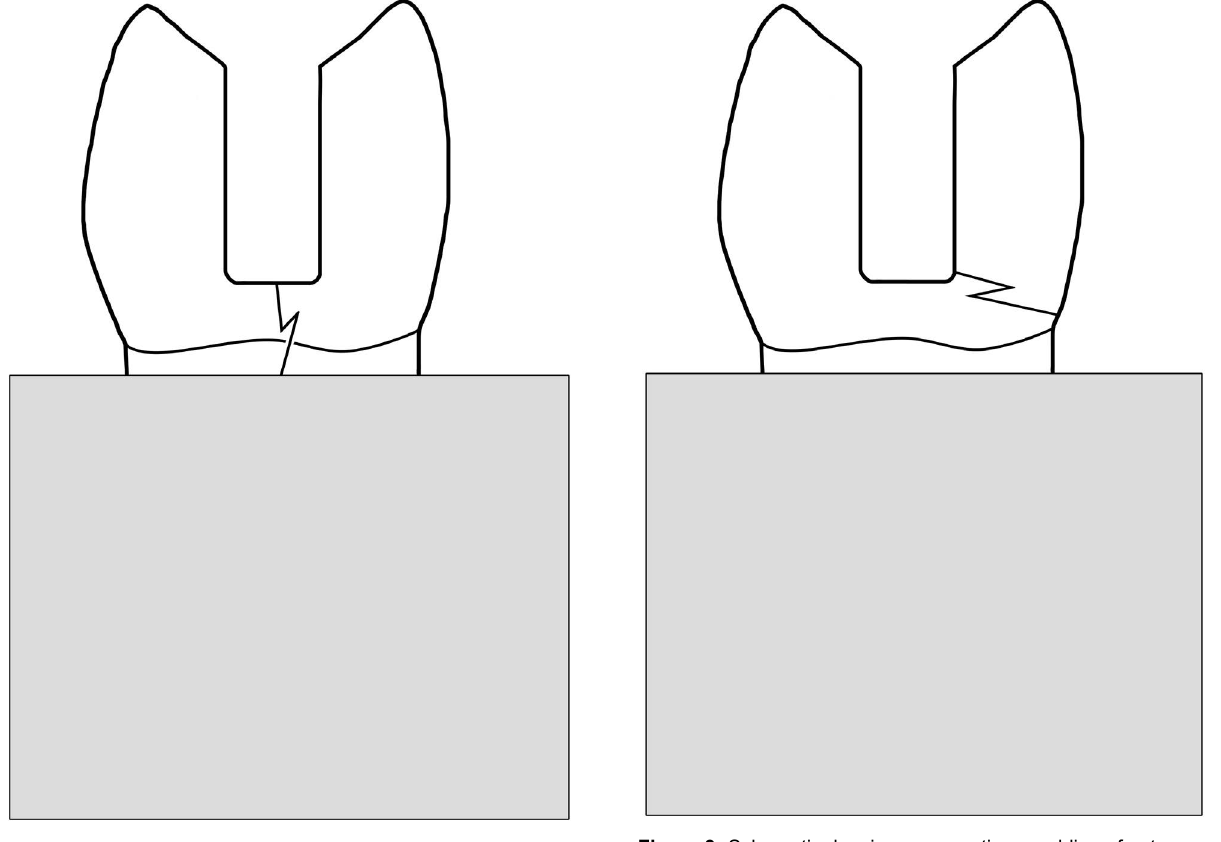
Figure 2- Schematic drawing representing a longitudinal fracture Figure 3- Schematic drawing representing an oblique fracture